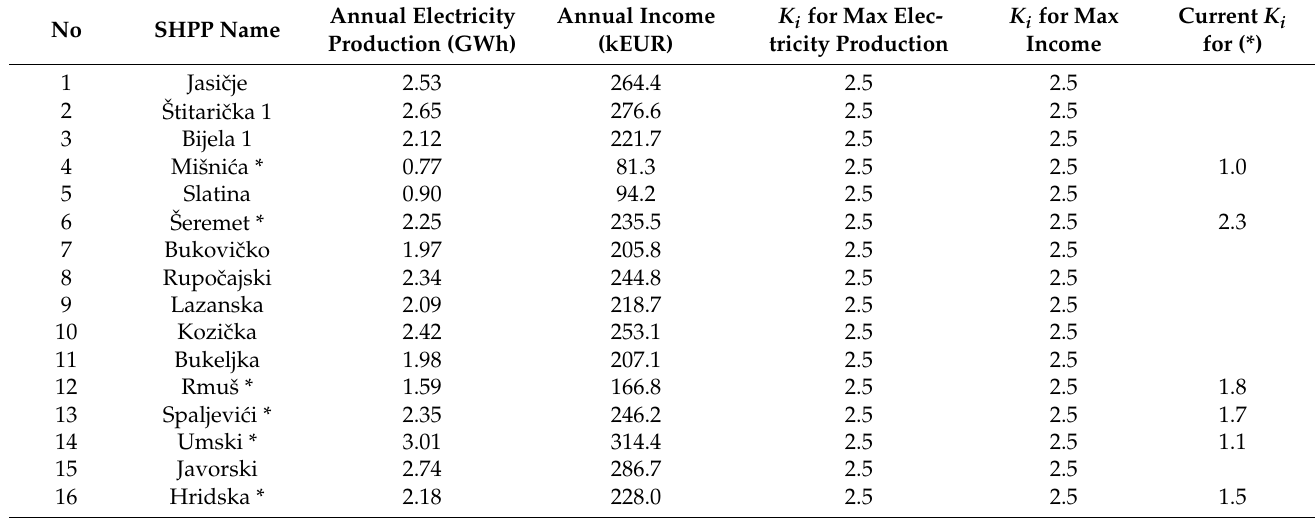
Table 3. Maximum annual production and income and corresponding SHPP installed parameter for SHPPs below 1 MW—Group I, (*—constructed plants).